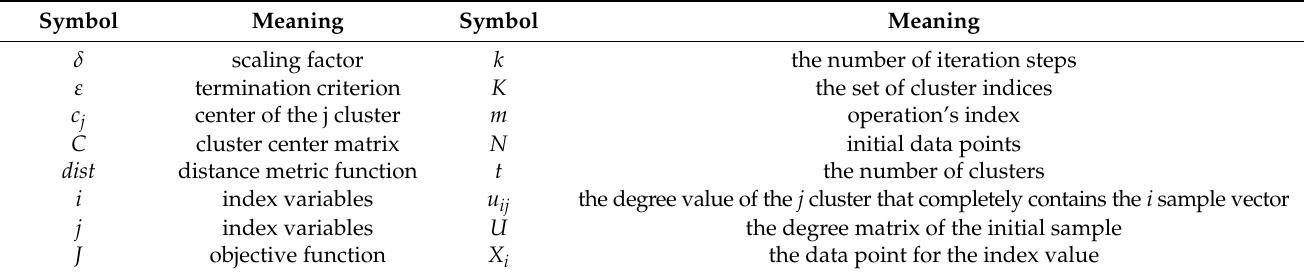
Table 1. Symbols and their meanings used in this